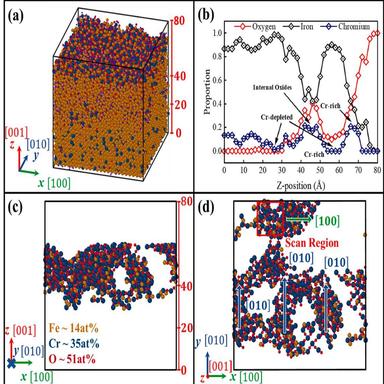
(a) The structure and (b) atomic distribution of Fe-9Cr steel after 1500 ps corrosion at 1500 K. Herein, (c) the front view and (d) the top view of internal Crrich nano oxides are shown, and yellow, cyan, red and blue balls represent iron, chromium, oxygen and hydrogen atoms, respectively. Herein, the scan region of (b) is marked in (d). (For interpretation of the references to color in this figure legend, the reader is referred to the web version of this article.)